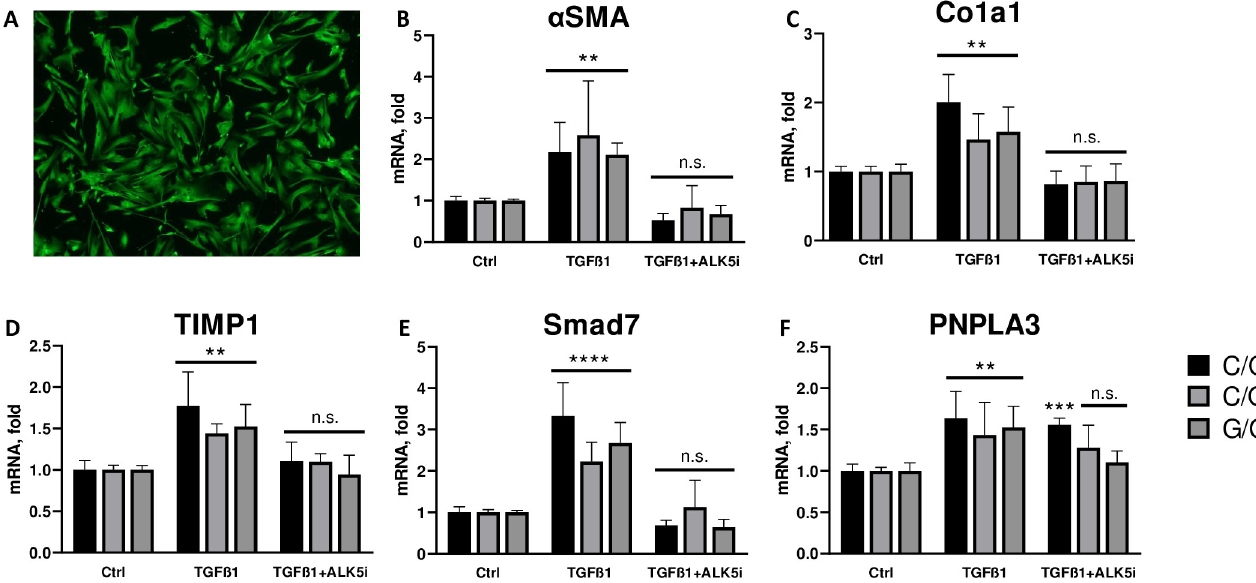
Fig 1. PNPLA3 genotype does not impact activation of HSCs in basal or TGF- β stimulated states. Primary HSCs (n = 20) were genotyped as wild-type, heterozygous, or homozygous for the I148M PNPLA3 mutation. After culture for 24h the cells were imaged and shown to have robust expression of GFAP, an identifying marker of hepatic stellate cells (A). These cells were then treated with or without 5ng/ml TGF- β and mRNA was isolated and qPCR was performed for markers of HSC activation. Baseline activation of HSC was assessed in control cells without TGF- β treatment and activated HSCs were assessed with TGF- β treatment for wildtype (black bar), heterozygous (light grey bar), and homozygous (dark grey bar) donors by expression of α -SMA (B), collagen 1 (C), TIMP1 (D), and SMAD7 (E). Levels of PNPLA3 (F) were measured across genotypes in baseline and TGF- β stimulated conditions. A small molecule ALK5 inhibitor (1mM) was added simultaneously with the TGF- β to serve as a positive control for reversal of activation. Values are mean +/- SD, p = ns within all treatments vs WT genotype by 1-way ANOVA.C/C = wild type PNPLA3; C/G = heterozygous for rs738409; G/G = homozygous for rs738409. n = 6.